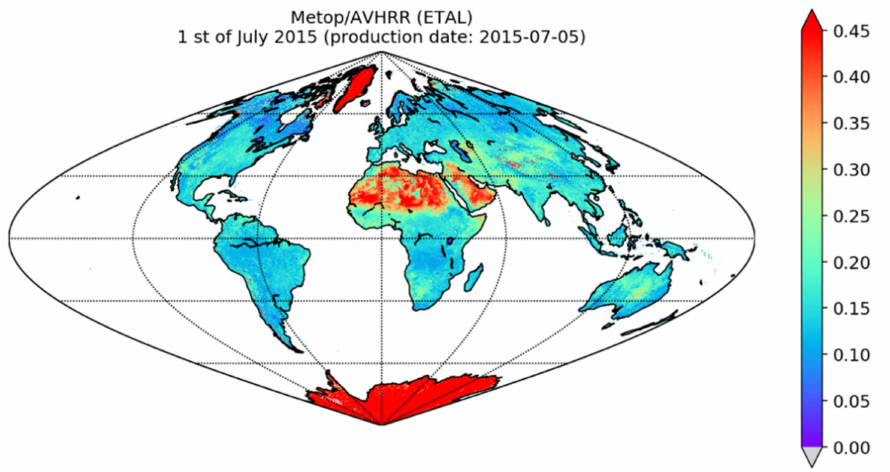
Figure 8. Total shortwave directional-hemispherical albedo (BB-DH) for 1 July 2015 based on Metop/AVHRR-3